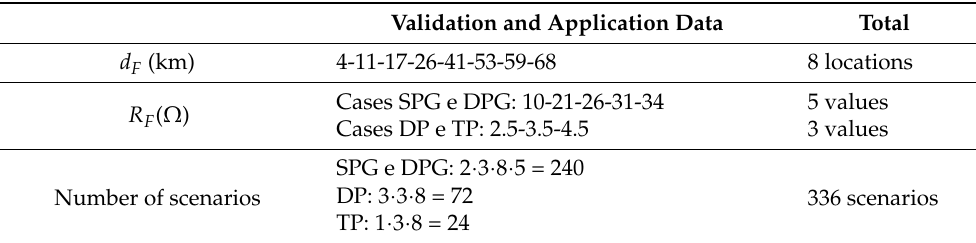
Table 5. Composition of fault scenarios: validation of ANN, application in NLO techniques and in the analytical method.